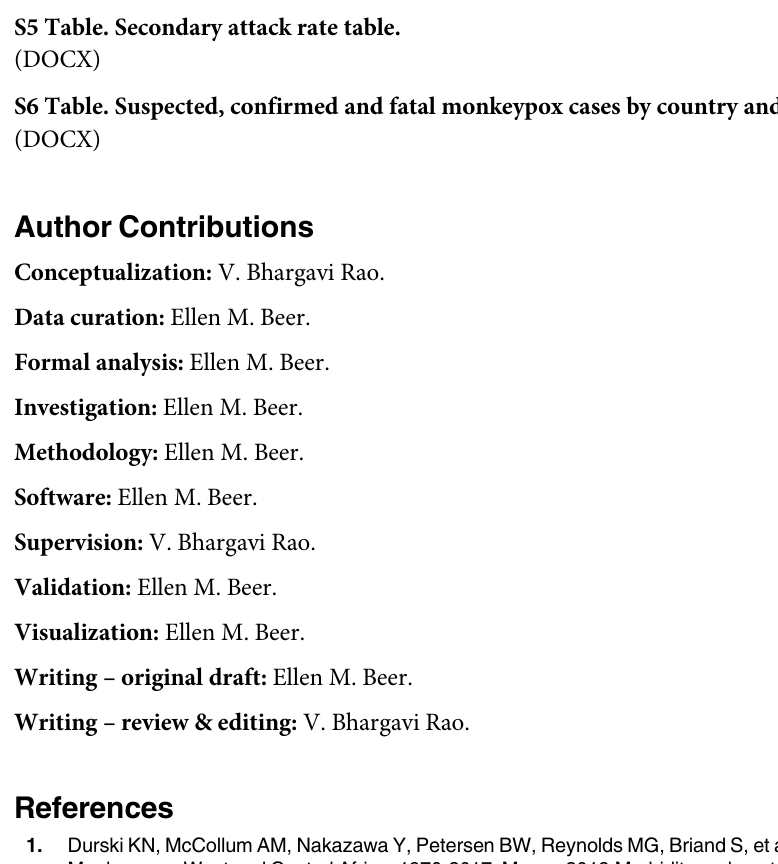
S2 Table. Age and sex characteristics by country and year. S3 Table. Summary of study findings on risk factors for primary introduction of monkey-